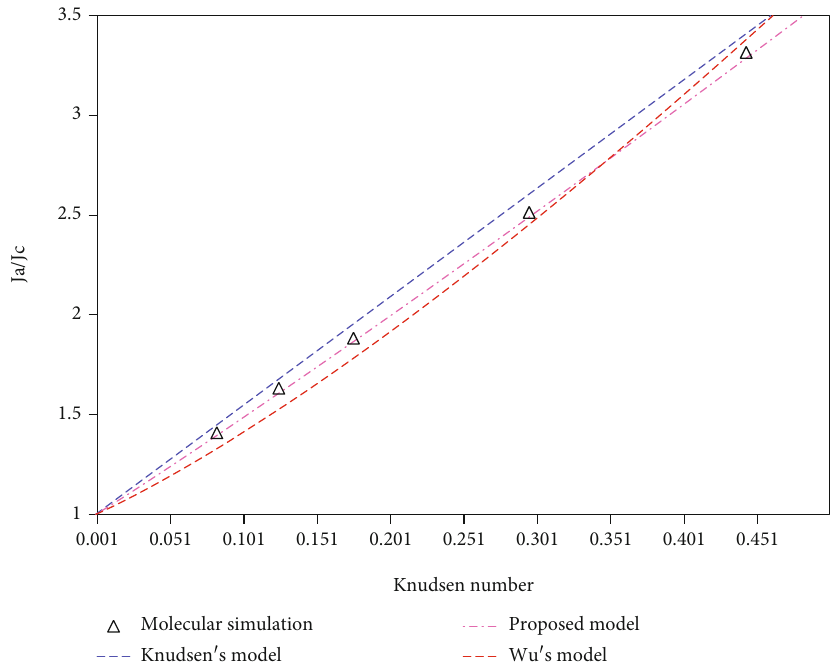
Figure 1: Comparison between proposed model and molecular simulation with low Kn